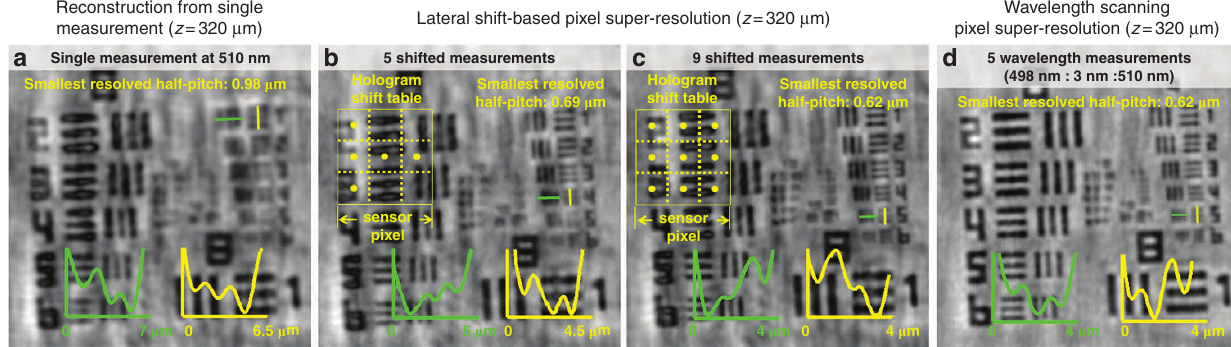
Figure 3 Resolution improvement introduced by wavelength-scanning pixel super-resolution. ( a ) Reconstruction from a single raw measurement captured by an image sensor chip with a pixel pitch of 1.12 μ m. ( b , c ) Lens-free reconstructions using lateral shift-based pixel super-resolution. b and c are reconstructed using super-resolved holograms synthesized from fi ve and nine sub-pixel-shifted raw measurements, respectively. The corresponding sub-pixel shifts of the raw measurements are marked within the hologram shift tables. ( d ) Reconstruction using wavelength-scanning pixel super-resolution; fi ve wavelengths are used within a scanning range of 498 – 510 nm and a scan step size of 3